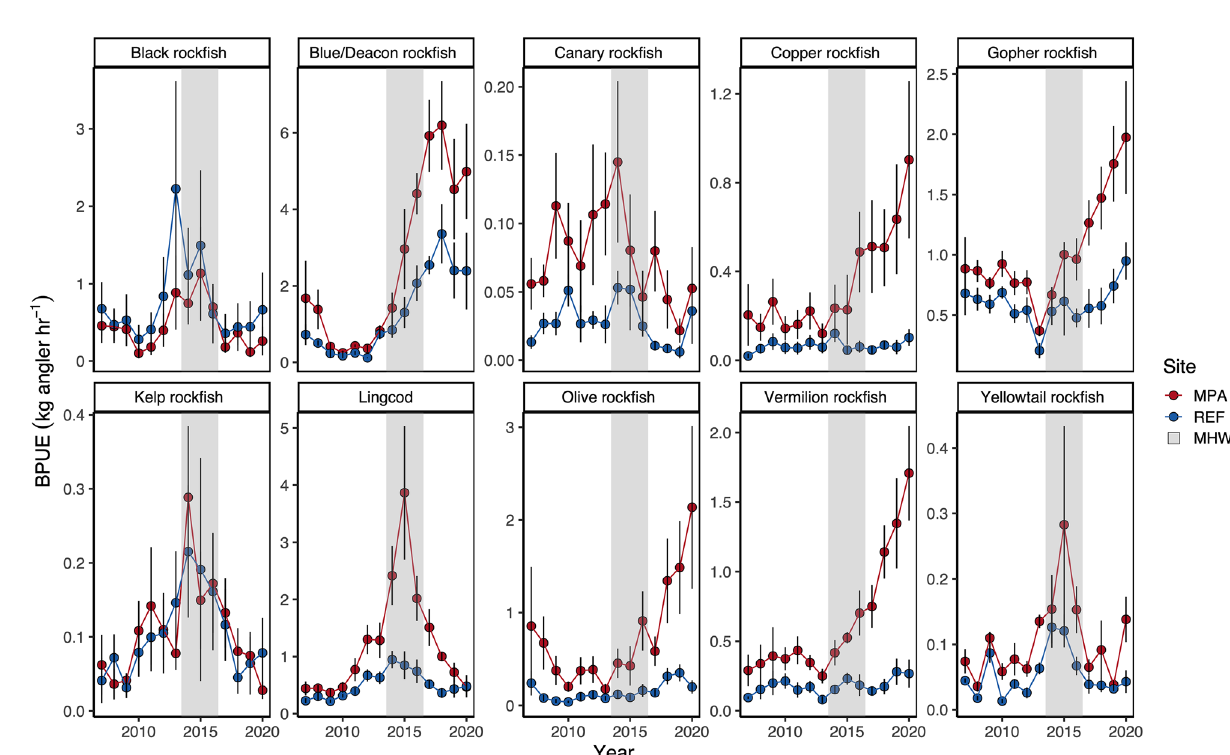
Figure 5. Trends in biomass per unit effort (BPUE) of the top ten most abundant fish species at MPA and reference (REF) sites before (2007–2013), during (2014–2016), and after (2017–2020) the marine heatwave (MHW). Points are annual means +/− 95%